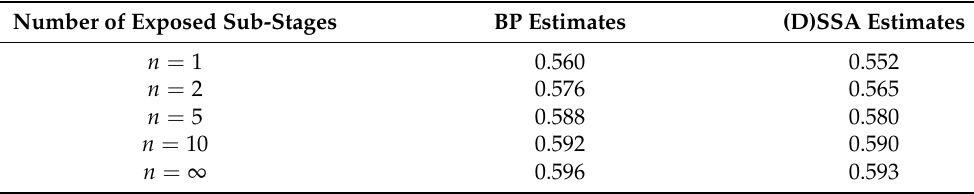
Figure 9. The distribution of the final sizes of 10 4 realizations for the CTMC model (3) with 10 exposed stages (simulated with SSA). Table 2. Comparison of probabilities of a minor outbreak for the stochastic epidemic models (3) with n = 1,2,5,10, estimated by BP and by distributions of final sizes of 10 4 realizations generated by SSA,